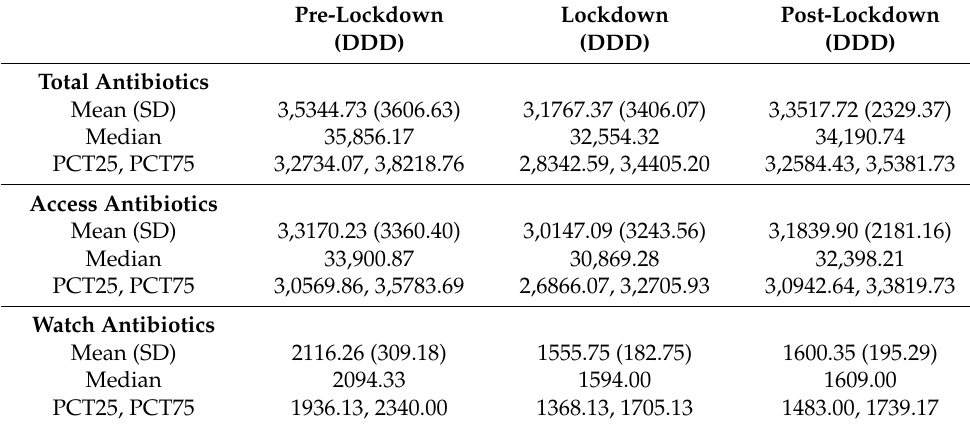
Table 1. Antibiotic consumption before, during and after lockdown